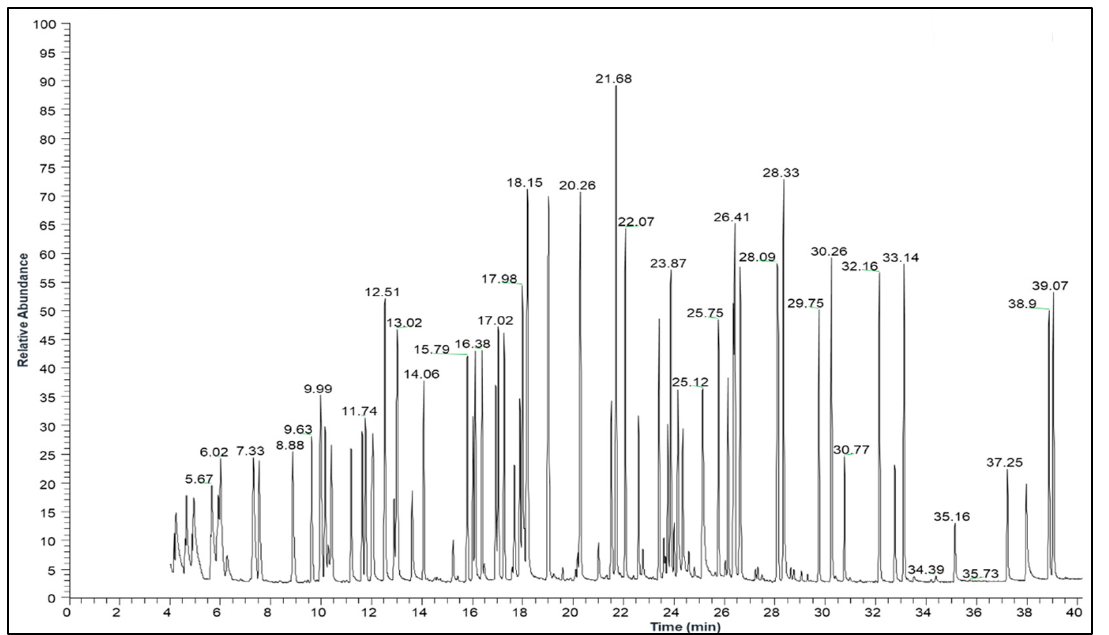
Figure 1. GC-MS full-scan chromatogram of the FS solution. The curve correlation coefficients (R) were in the range 0.9999–0.9943 with the lower associated with eugenol and santalol.